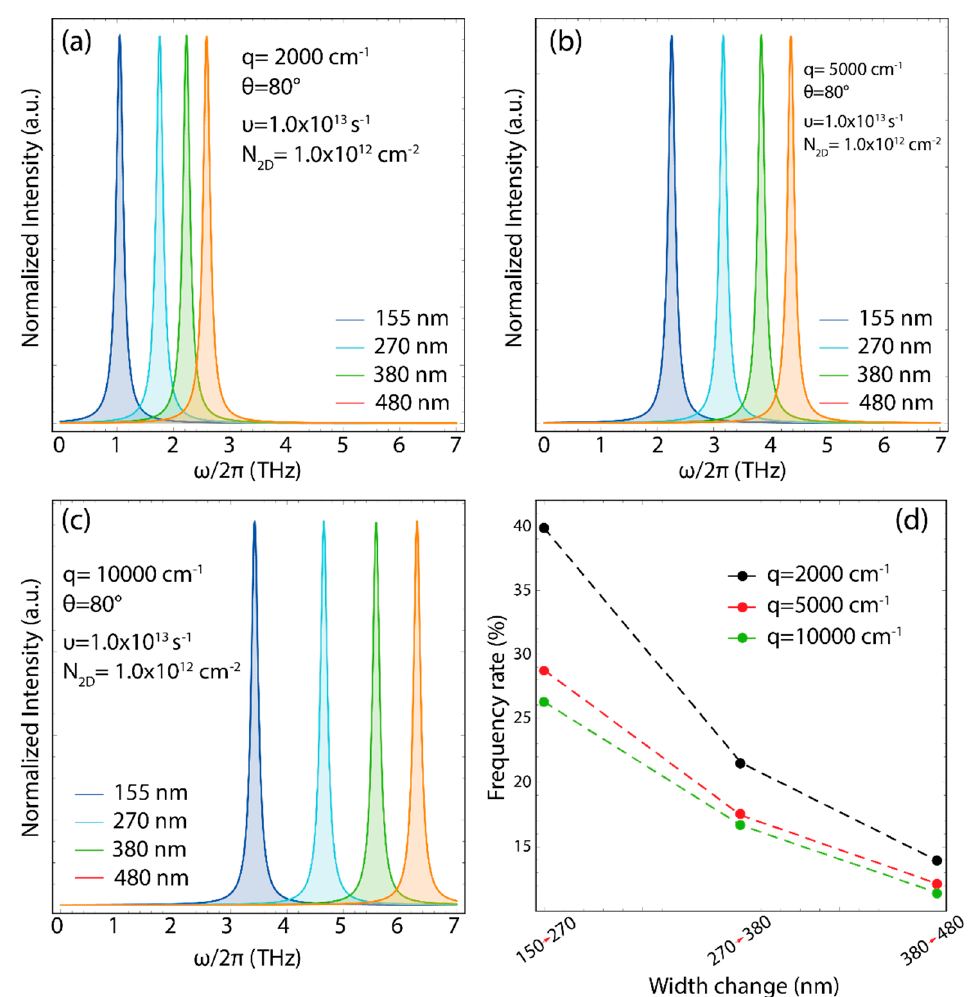
Figure 9. Plasmon excitation lifetime ( ≤ 7 THz) at ( a ) q = 2000 cm − 1 , ( b ) q = 5000 cm − 1 , ( c ) q = 10,000 cm − 1 ; considering different ribbons widths (155, 270, 380, and 480 nm). ( d ) Percentage variation in plasmon frequency by increasing ribbon width for three different q values ( q = 2000, 5000, 10,000 cm − 1 ). The parameters of Equation (4) have been fixed as: N 2 D = 1.0 × 10 12 cm − 2 , θ = 80, ν = 1.0 × 10 13 s − 1 , and v F = 0.829 × 10 6 m s − 1 . The plasmon spectra were calculated using the Lorentzian shape function to a maximum value of 1 with FWHM =